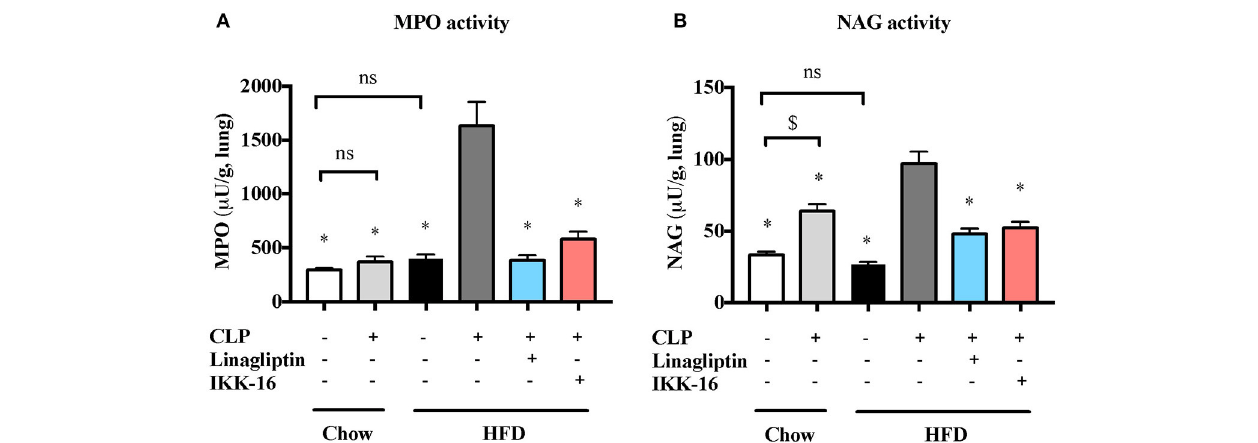
FIGURE 5 | Effects of CLP and linagliptin or IKK-16 post treatment on neutrophil/macrophage infiltration in the lung in mice with pre-existing T2DM. Mice from chow and HFD groups were randomized to undergo CLP or sham surgery. At 1h after CLP, mice on HFD were randomized to receive linagliptin (10 mg/kg, i.v.), IKK-16 (1 mg/kg, i.v.), or vehicle (2% DMSO, 3 ml/kg). At 24h after CLP, lung samples were collected and neutrophil and macrophages infiltration were measured as the (A) MPO and (B) NAG activities. Data was analyzed using one-way ANOVA followed by Bonferroni’s post-hoc test and expressed as mean ± SEM for n number of